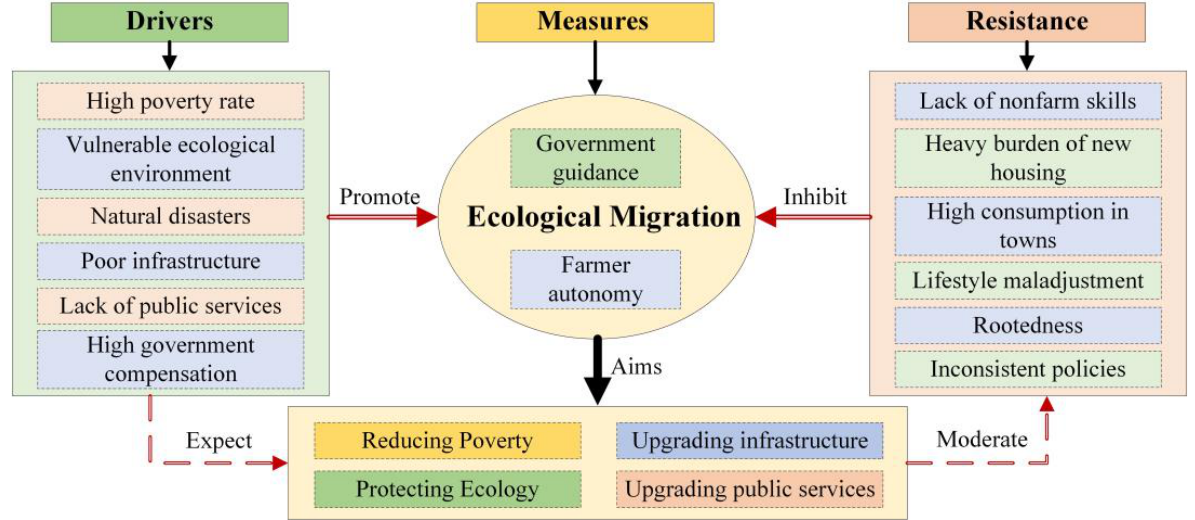
Figure 11. Framework of dynamics and resistance to the implementation of ecological migration.